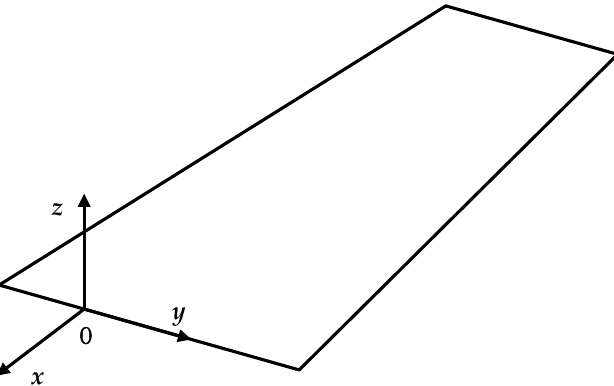
Figure 2. The morphing wing coordinate system diagram.